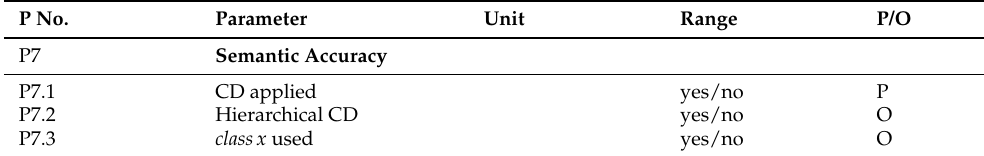
Table 11. Parameters for semantic